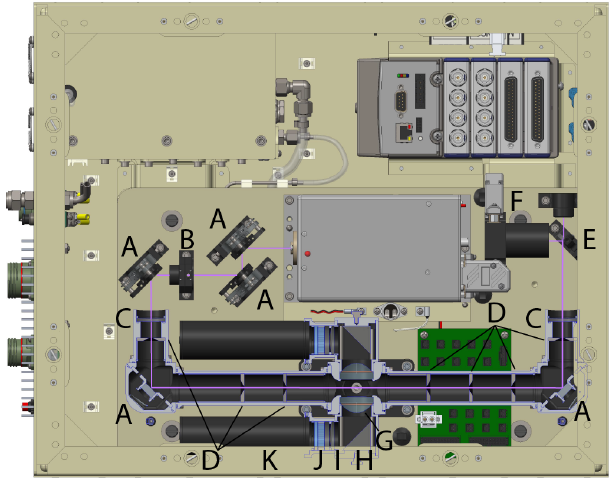
Figure 2. CAFE instrument top view, with dust covers removed and a cutaway of the detection cell to show its optical compo- nents: (A) steering mirrors, (B) half-wave plate and collimating lens, (C) cell windows, (D) laser baffles, (E) beam sampler, (F) laser power monitor, (G) aspheric lens, (H) prism dielectric mirror, (I) op- tical filters, (J) lens, and (K) photomultiplier tube.